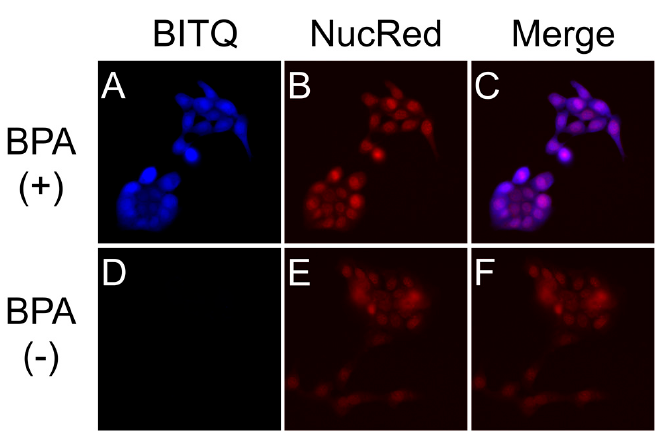
Figure 6. Representative fl uorescence images of T3M-4 cells: ( A – C ) BPA-present group, ( D – F ) BPA- absent group. ( A , D ) Fluorescence images after 5 min incubation with BITQ (10 µM) (DAPI-V fi lter: Ex: 395/25 nm, Em: 460/50 nm); ( B , E ) nucleus staining using NucRed Live647 (Cy5 fi lter: Ex: 620/60 nm, Em: 700/75 nm); and ( C , F ) merged images of fl uorescence from BITQ and NucRed Live647.